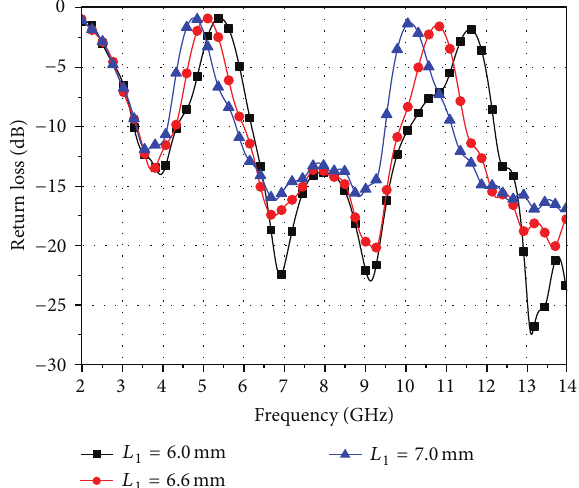
Figure 5: Tunable band-notched characteristics of CRA A with all switches